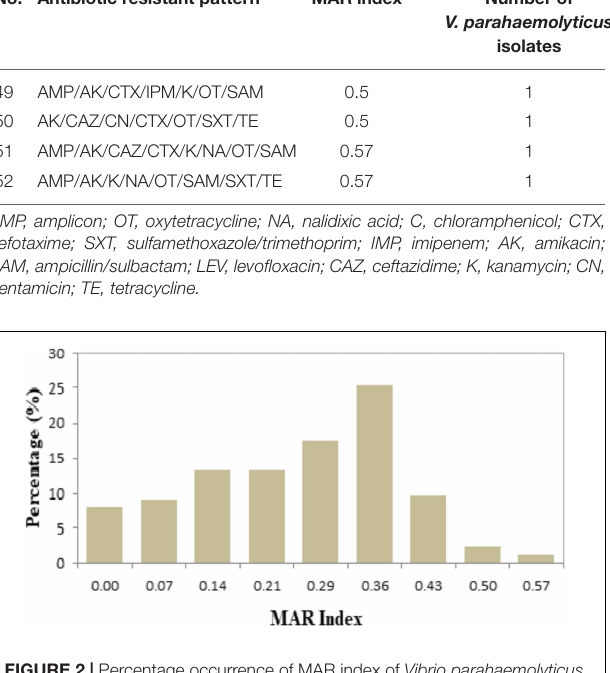
FIGURE 2 | Percentage occurrence of MAR index of Vibrio parahaemolyticus isolates from all fish samples of different sampling locations. The isolates exhibited MAR index from 0.00 to 0.57, representing that the V. parahaemolyticus isolates are resistant to 0–8 types of antibiotics